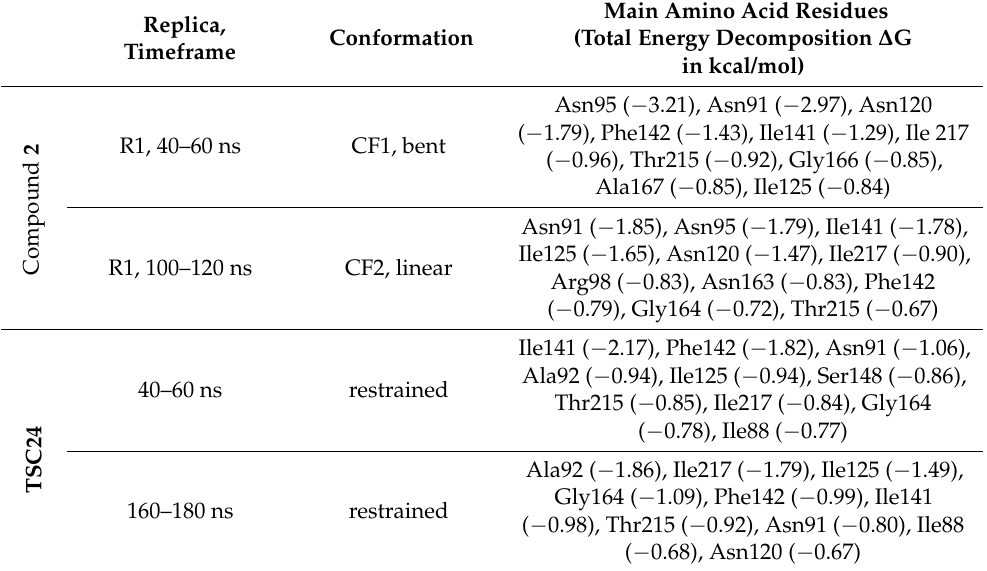
Table 1. The results of MM/GBSA binding free energy analysis for the selected timeframes in which ligands 2 and TSC24 adopted a particular conformation. All residues with binding free energy contributions above 0.5 kcal/mol are listed and ordered by descending